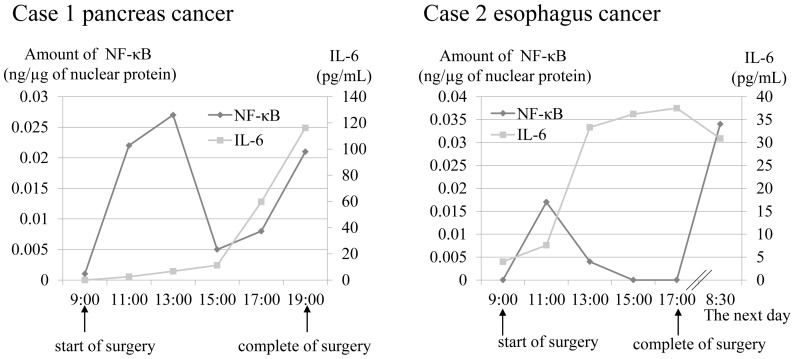
Kinetics of activation of NF-κB in the perioperative period.NF-κB activities and IL-6 were measured in the perioperative period for esophagus and pancreas cancers from two individuals.